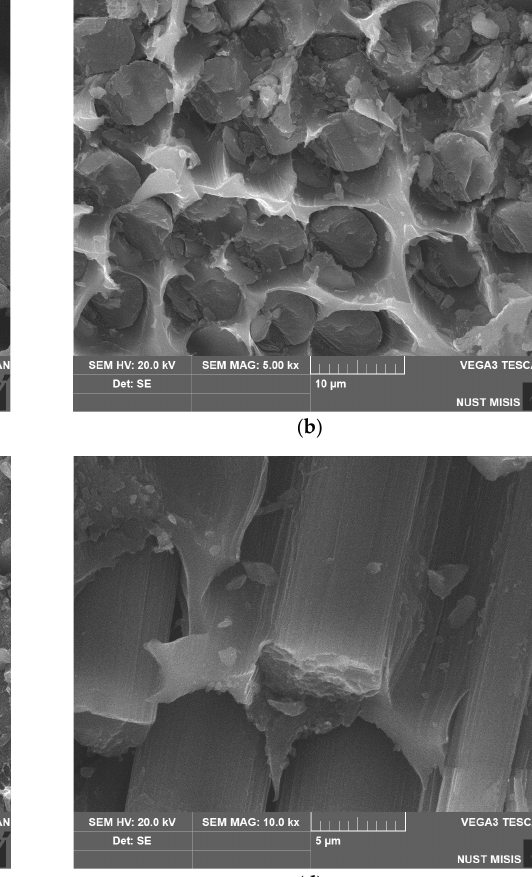
Figure 10. SEM photos of 50/50 composite materials reinforced with ( a ) initial CF, ( b ) TO 300 fibers, and ( c , d ) TO 500 fibers.